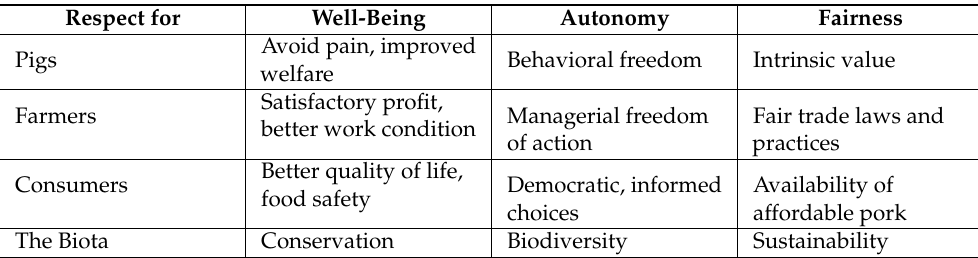
Table 4. Bioethics matrix for developing swine welfare assessment